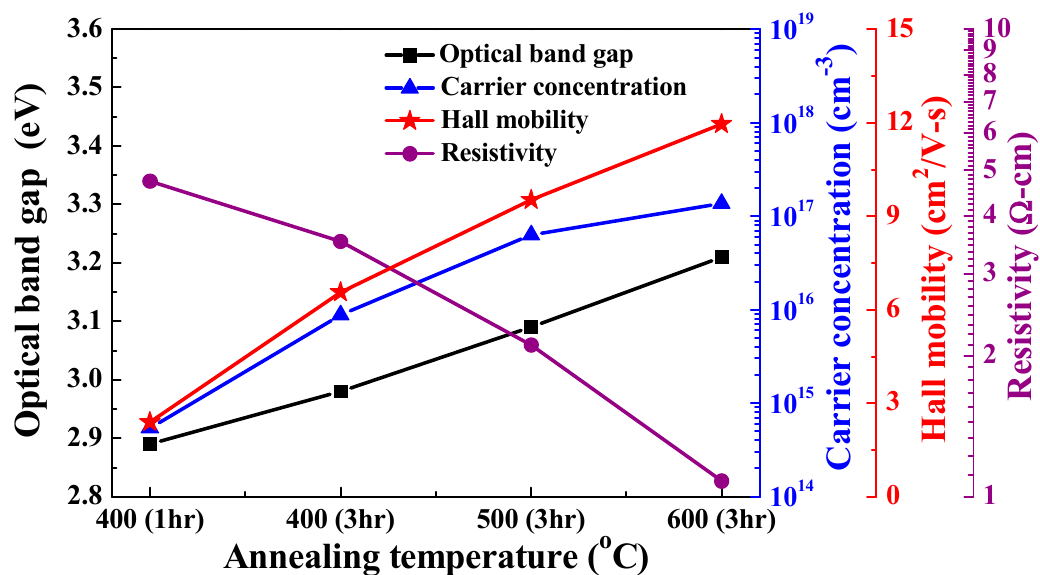
Figure 6. Optical band gap, carrier concentration, mobility, and resistivity of the L2NiO thin films as a function of annealing temperatures and times. Table 2. Elements of L2NiO thin films as a function of annealing temperature and time. Ni (at%) O (at%) Li (at%)